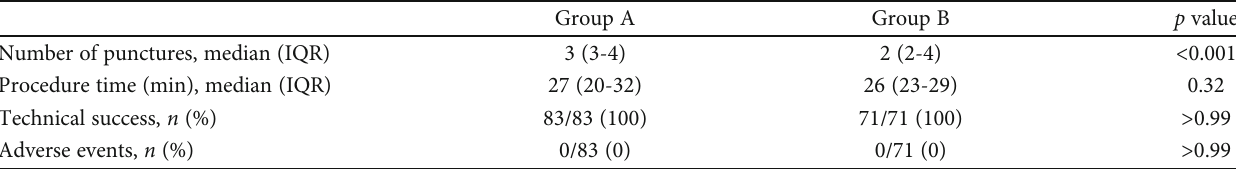
Table 4: Procedural comparisons between the conventional (Group A) and Franseen (Group B) needle groups.